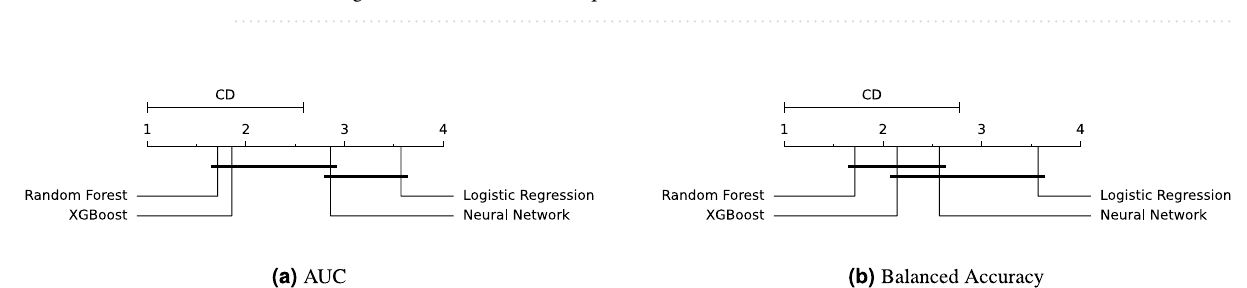
Table 4. Clinical trial termination classification results, using single model without random under sampling (a), and random under sampling based ensemble model (b) trained using all features. A * indicates where the ensemble classifier is significantly different from its single model classifier counterpart at p < 0.05 , and ** indicates a higher level of confidence at p < 0.001 .